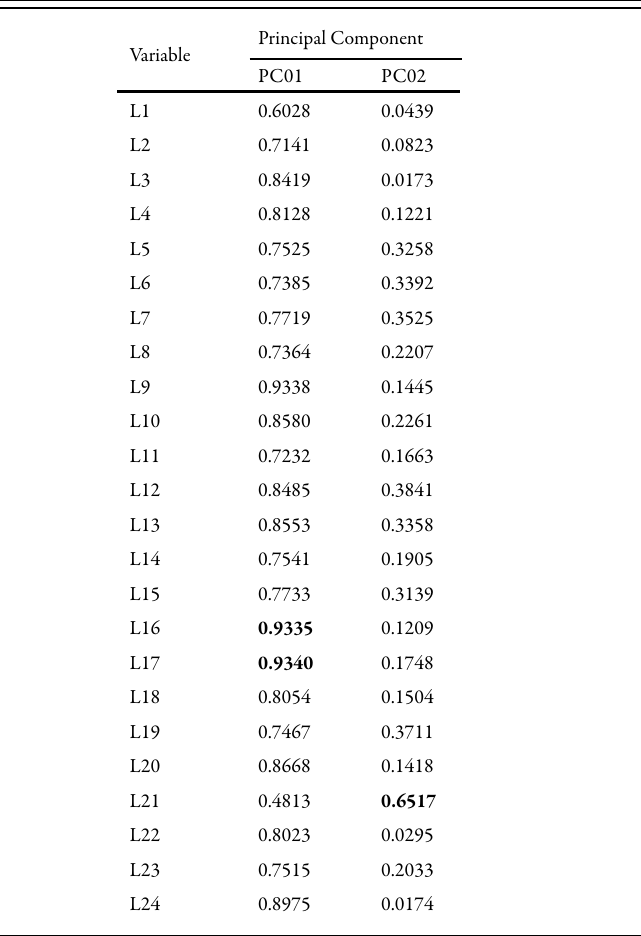
Table 2. Principal component analysis between males and females of Tetrapedia diversipes , Bahia of Reconcavo region,